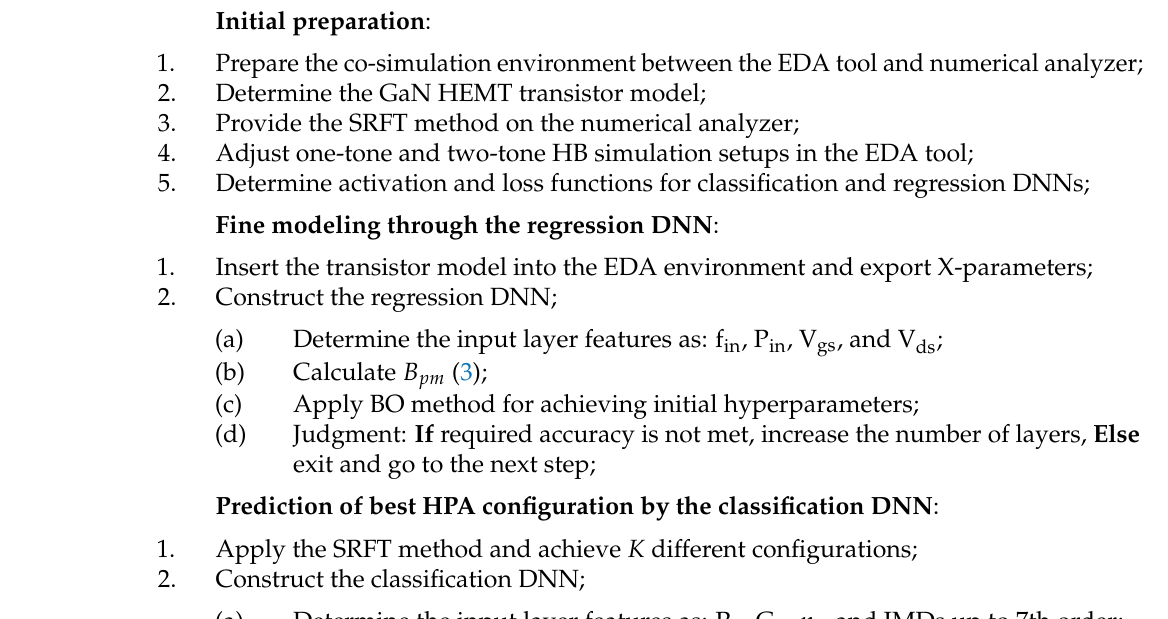
Algorithm 1 Automated multi-tone HB optimization